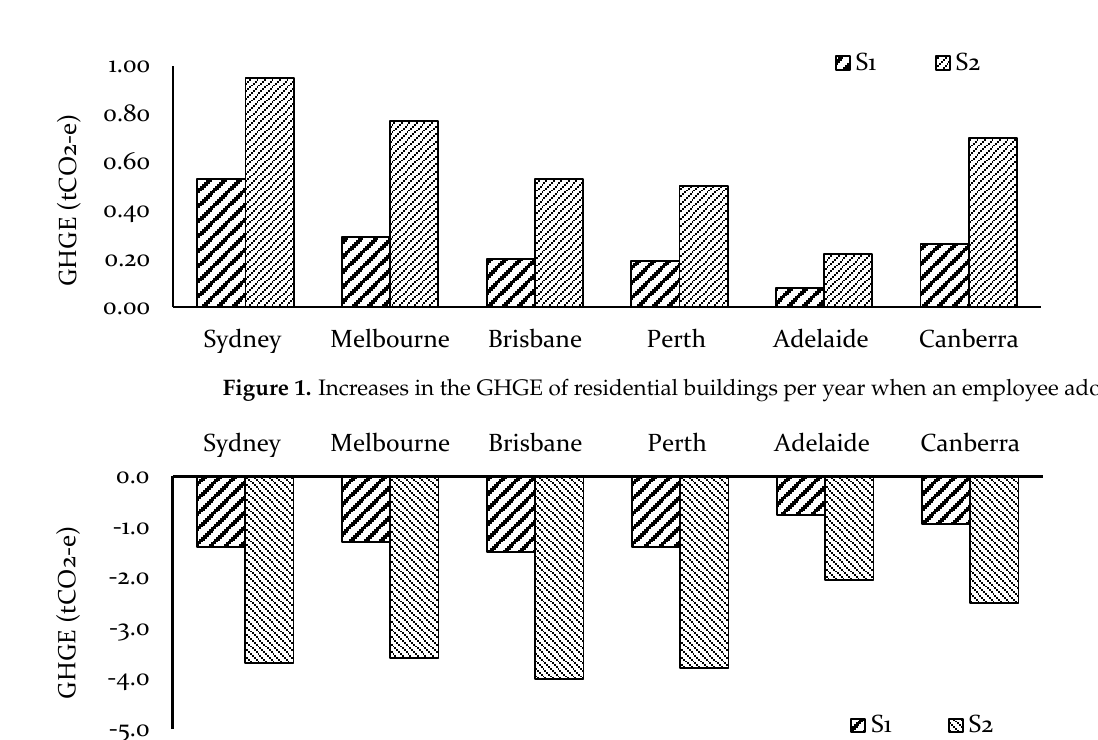
Figure 2. GHGE changes from transportation per year when an employee adopts WFH. Figure 2 highlighted that about 1.5 tCO 2 -e/year GHGE was reduced by an employee from Brisbane when practising WFH for 1.5 days per week. This reduction was about 2% and 1% lower for employees in Melbourne and the other four cities, respectively. While employees adopted WFH for 4 days per week, the GHGE reduction was increased to 80% in all six cities. A similar trend of GHGE reduction from transport was found in previous studies [7,10,48]. Figures 1 and 2 highlight that about 24% and 68% of total GHGE can be reduced by an employee, respectively, whenpractising WFH for 1.5 days and 4 days per week over a year. A recent study by Guerin [10] highlighted that the WFH practice could reduce not only GHGE but also other pollutants which can cause human toxicity, abiotic depletion, and photochemical oxidation.